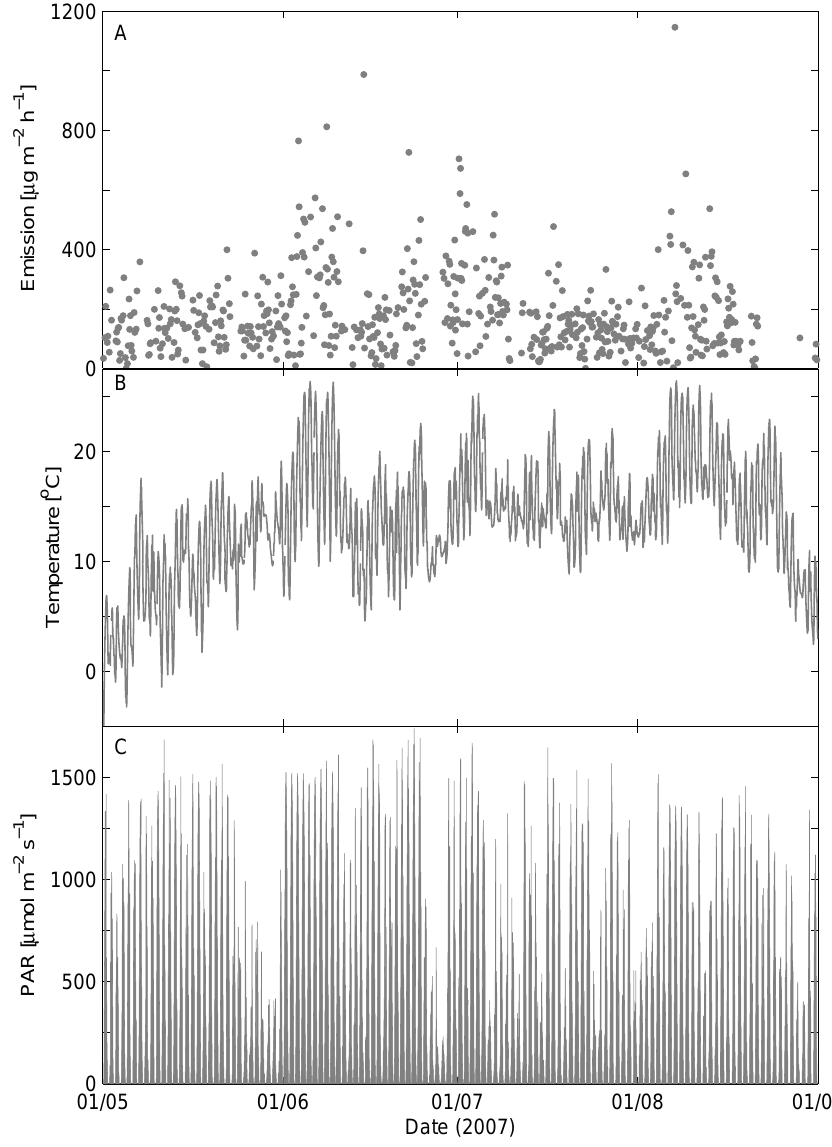
Fig. 1. Monoterpene emissions, air temperature, and photosynthetically active radiation (PAR) during the summer 2007. uncertainty in the estimates of the contribution of de novo emissions determined with the non-linear regression anal- ysis (see Sect. 3.2). Further measurements are needed to reveal reasons for the insignificant night-time emission– temperature